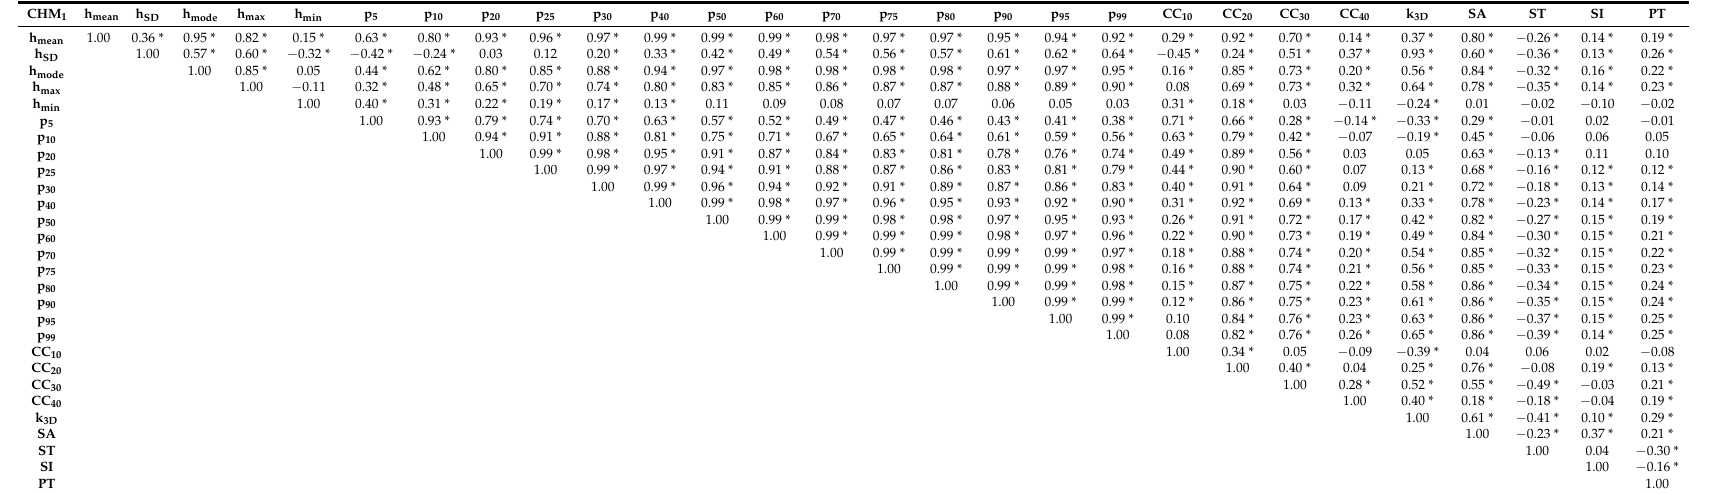
Table A1. Pearson correlation coefficients (r) between the independent variables (CHM metrics and FMP variables) calculated on the modeling dataset for the